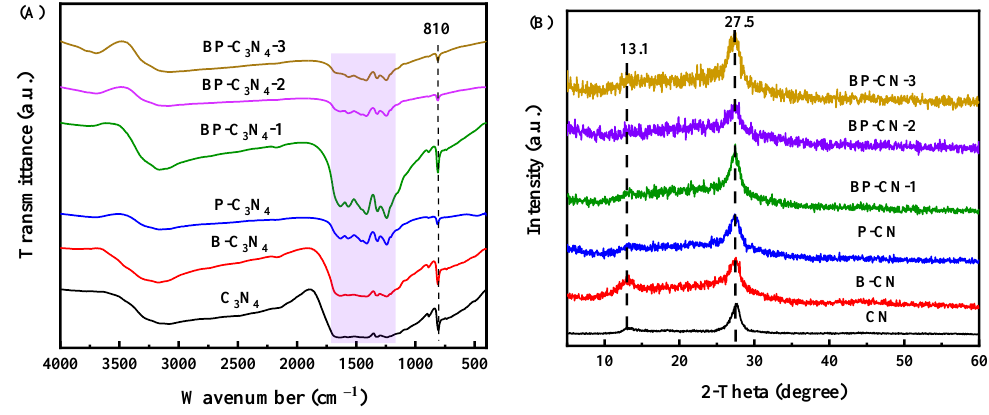
Figure 2. ( A ) FT-IR spectra, ( B ) XRD patterns of synthesized catalysts.